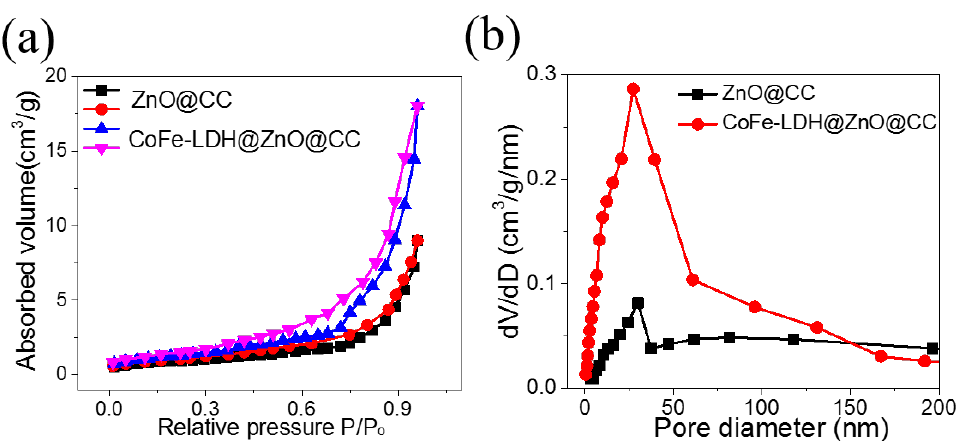
Figure 4. ( a ) N 2 -sorption isotherms of ZnO@CC and CoFe-LDH@ZnO@CC; ( b ) BJH pore-size distri-